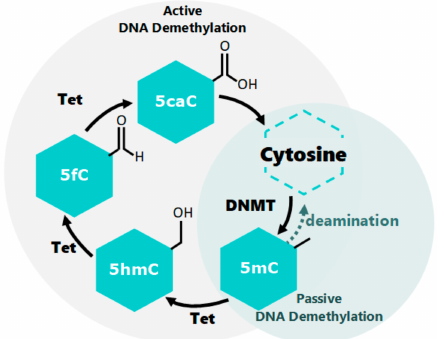
Figure 1. DNA demethylation and methylation: DNAm in eukaryotes occurs mainly at cytosine’s fifth carbon atom, catalyzed by de novo methyltransferases ( DNMT ). Active DNA demethylation involves the successive oxidation of the 5-methyl-cytosine (5-mC) to 5-hydroxymethyl-cytosine (5- hmC), to 5-formyl-cytosine (5-fC) , and then to 5-carboxy- cytosine (5-caC) , catalyzed by the Ten-eleven translocation enzyme family (Tet). Passive DNA demethylation occurs during replication due to the absence of methylation by DNMT1 across several rounds of replication. Figure by Gabriela Olivares-Castro